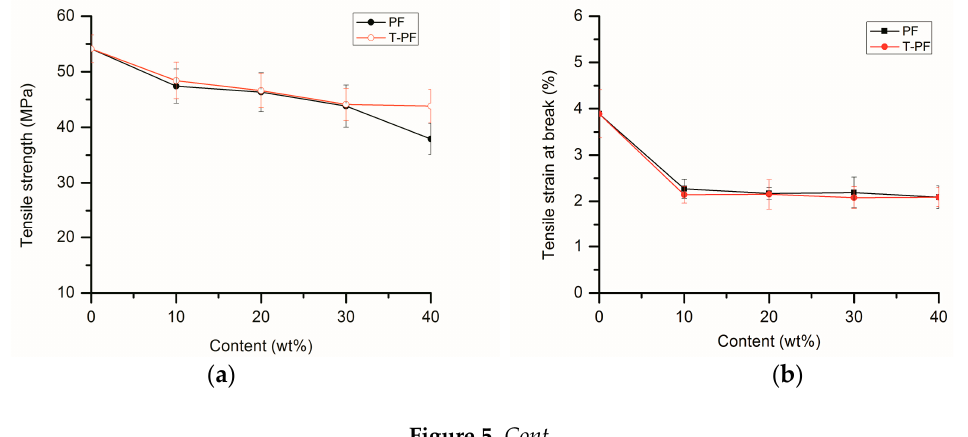
Figure 4. The coupling schematic of PF and titanate coupling agent (NDZ-311).